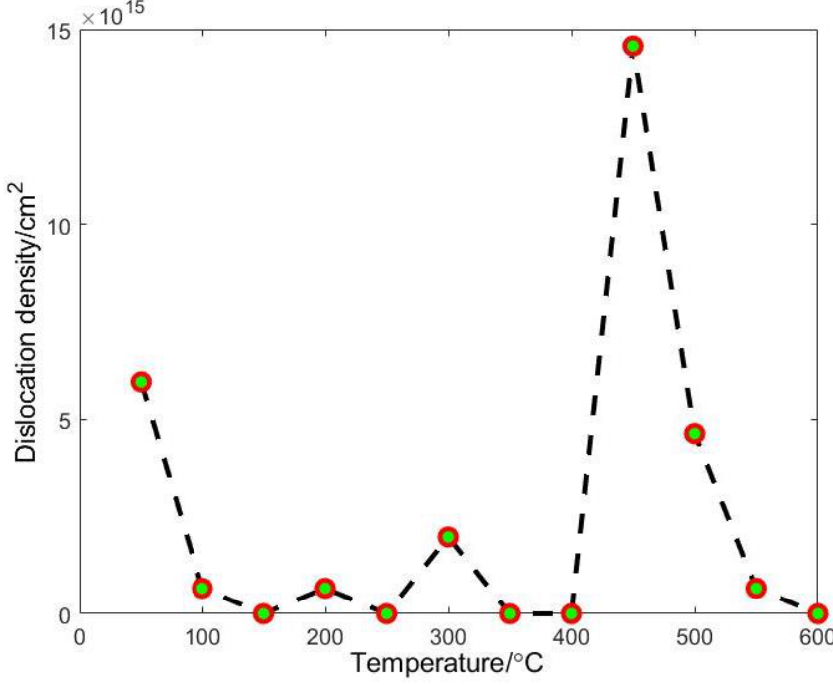
Figure 9. Variation of dislocation density with temperature.